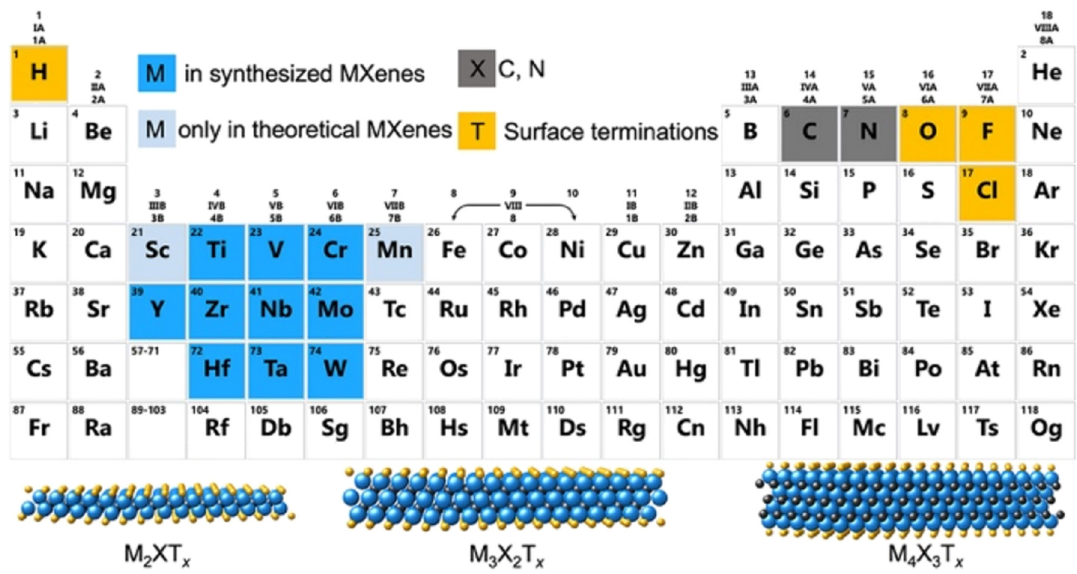
Figure 1. Periodic tables that display the elements necessary to make MXenes. The bottom of the figure contains the schematics for three typical MXene structures. Copyright 2019 ACS Publications.